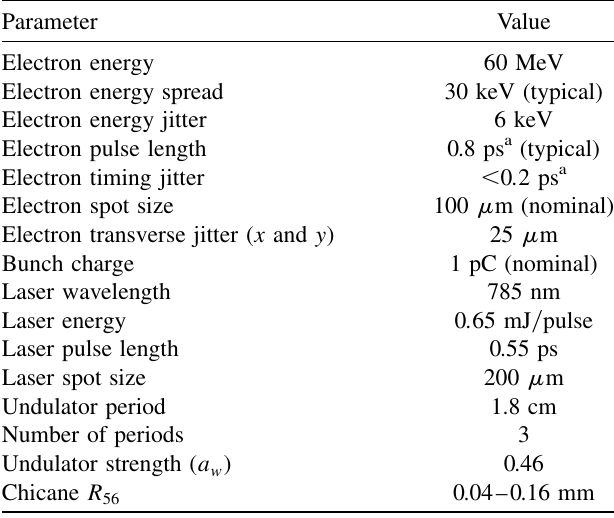
TABLE I. Experimental parameters for attosecond bunch train production. All widths are given as FWHM.